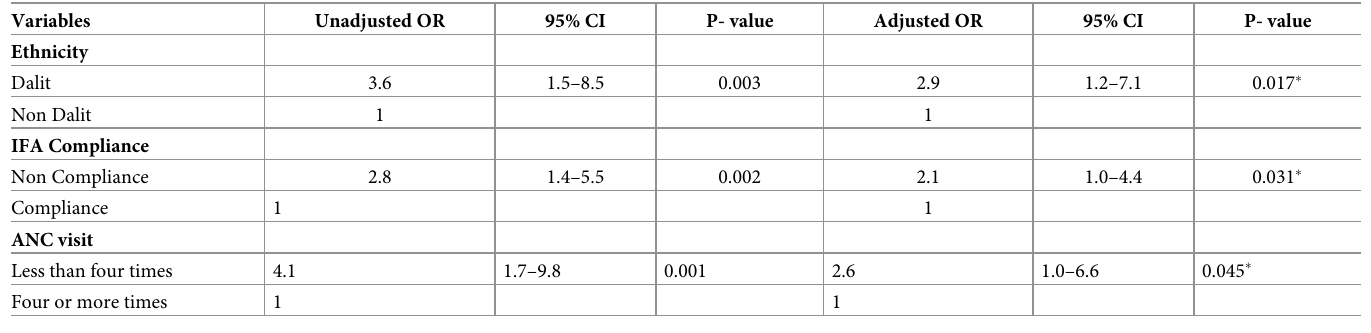
Table 2. Factors associated with low birth